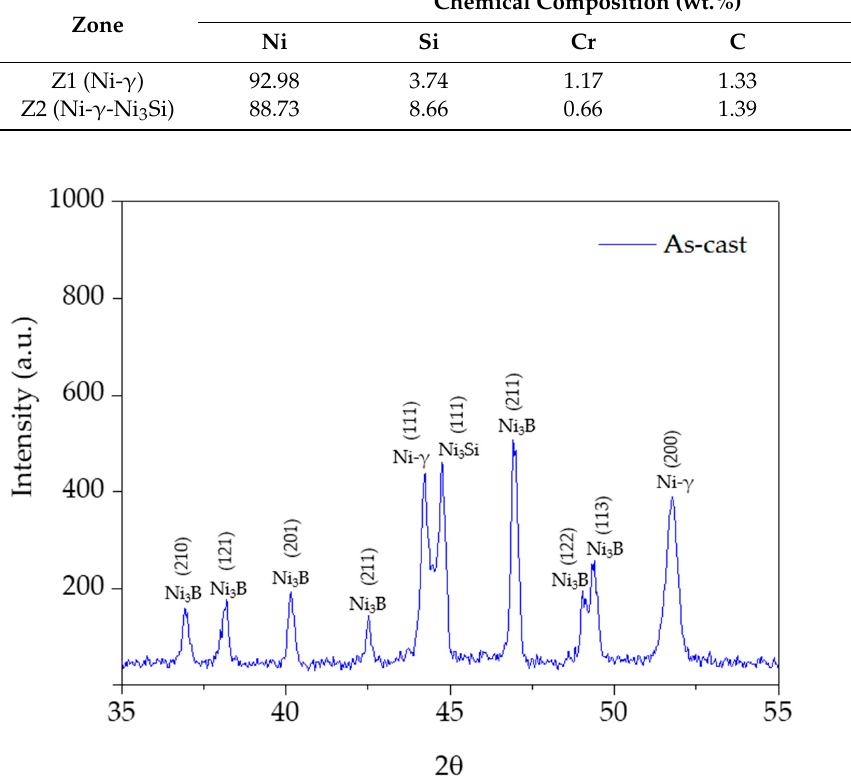
Figure 3. XRD pattern of the as-cast NiSi3B2 specimen, exhibiting intense peaks at the range of 2 θ = 35°–55°, corresponding to the Ni 3 B, Ni 3 Si and nickel-austenite (Ni- γ ) phases.